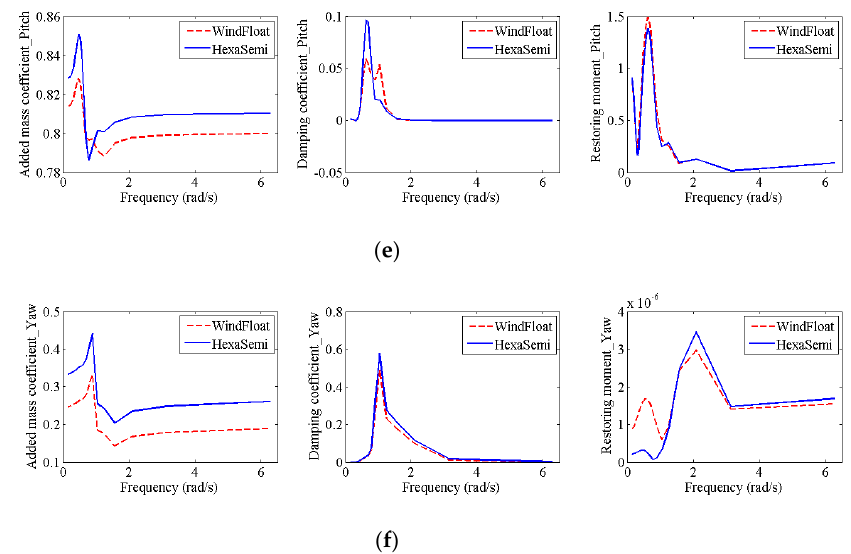
Figure 4. The comparisons of hydrodynamic coefficients in all six DOFs: ( a ) surge, ( b ) sway, ( c ) heave, ( d ) roll, ( e ) pitch, ( f ) yaw.